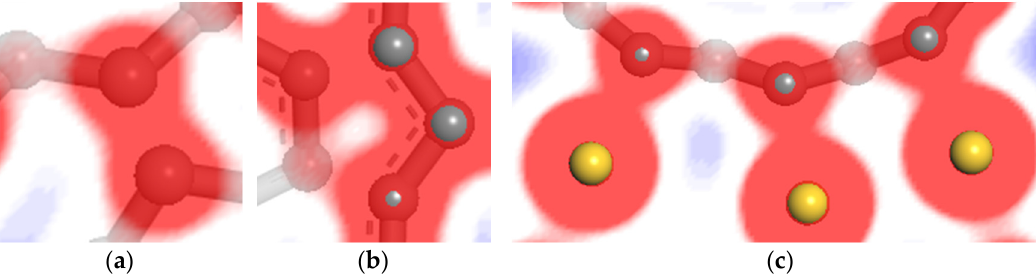
Figure 13. Electrostatic potential at the interface of DWCNT contacting with gold. ( a ) region A; ( b ) region B; ( c ) region C.